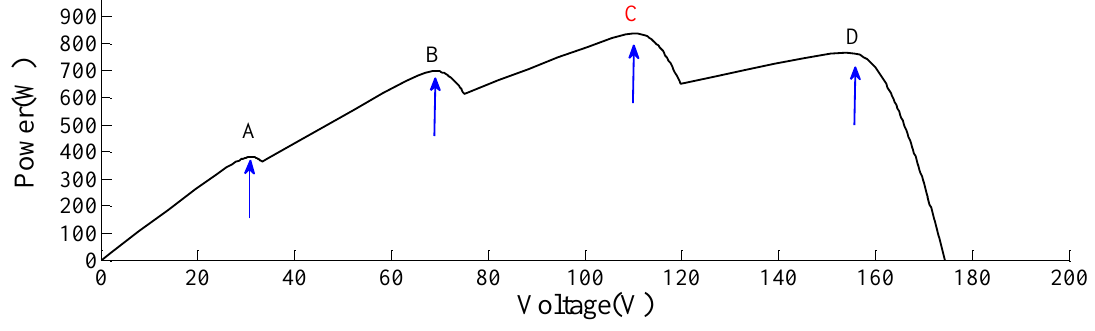
Figure 5. P-V curve of PV array under the first shade condition.